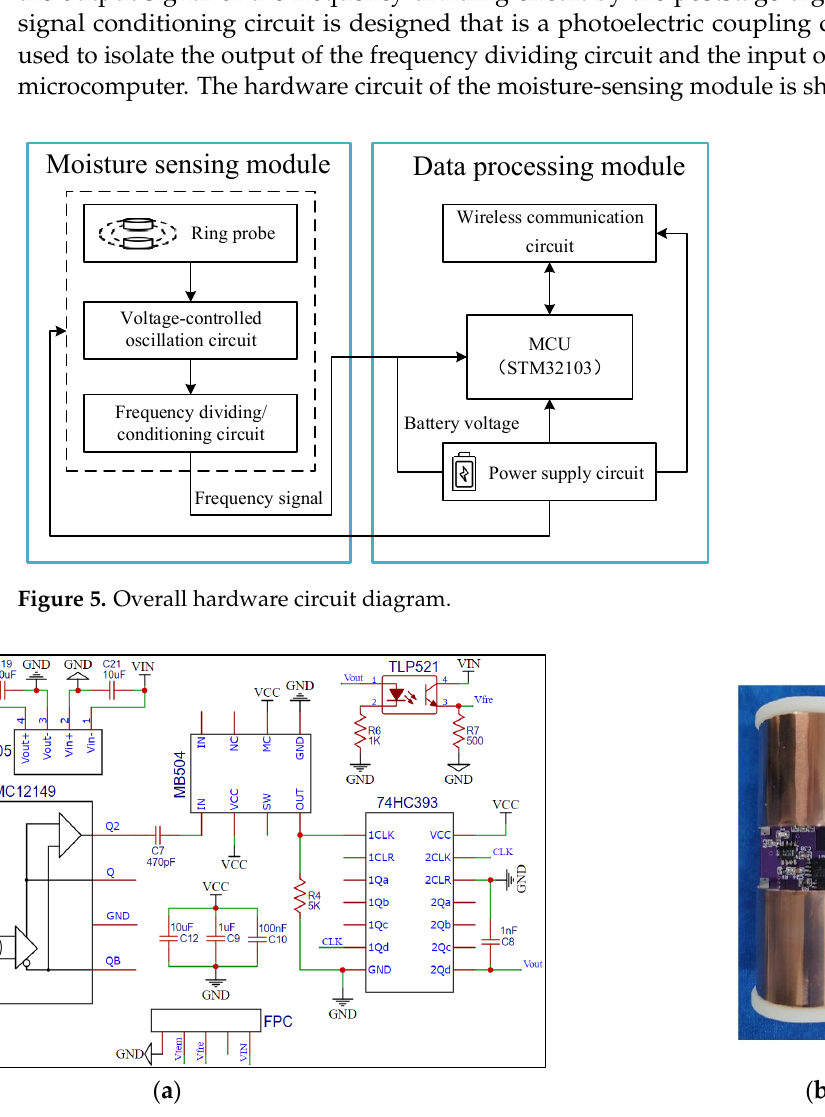
Figure 6. Hardware circuit of the moisture-sensing module. ( a ) Circuit schematic; ( b ) PCB and phys- ical drawings. physical